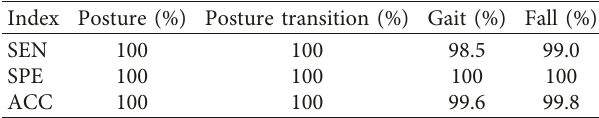
Table 4: Results of posture, posture transition, gait, and